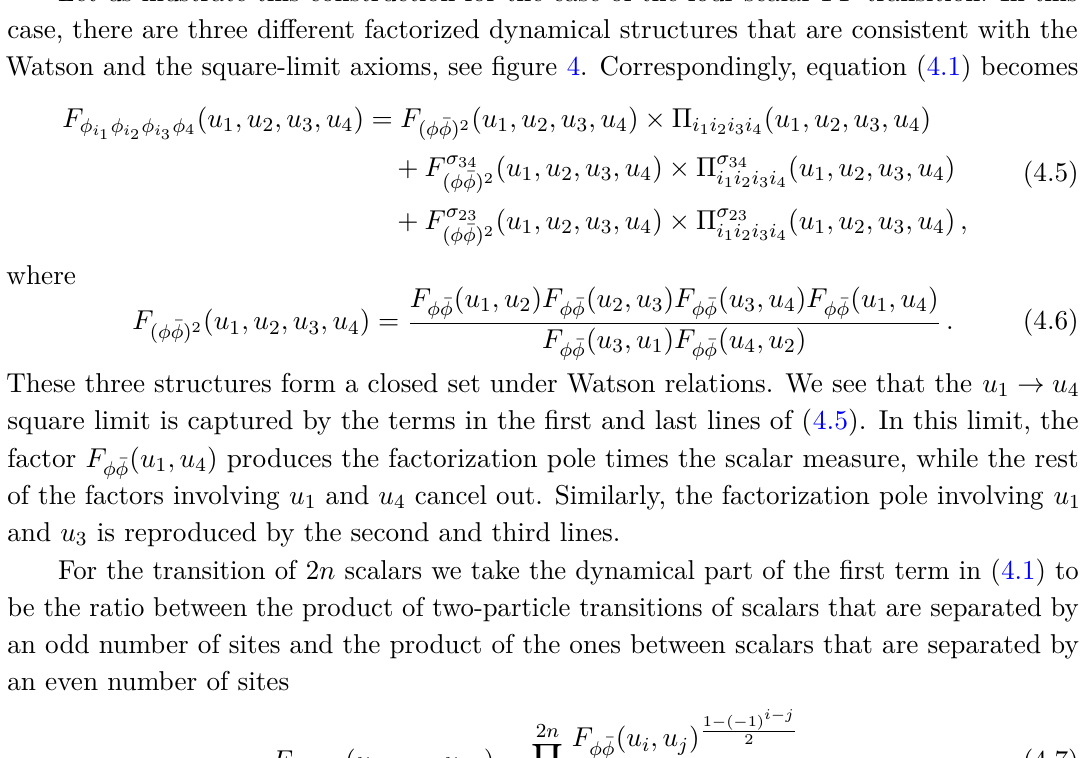
Figure 3 . The scalar S-matrix at equal rapidities is a permutation (4.4). As a result, the S- matrices in the second term in the square-limit axiom (2.5) cancel in pairs, S ( u where u = u = v 1 n